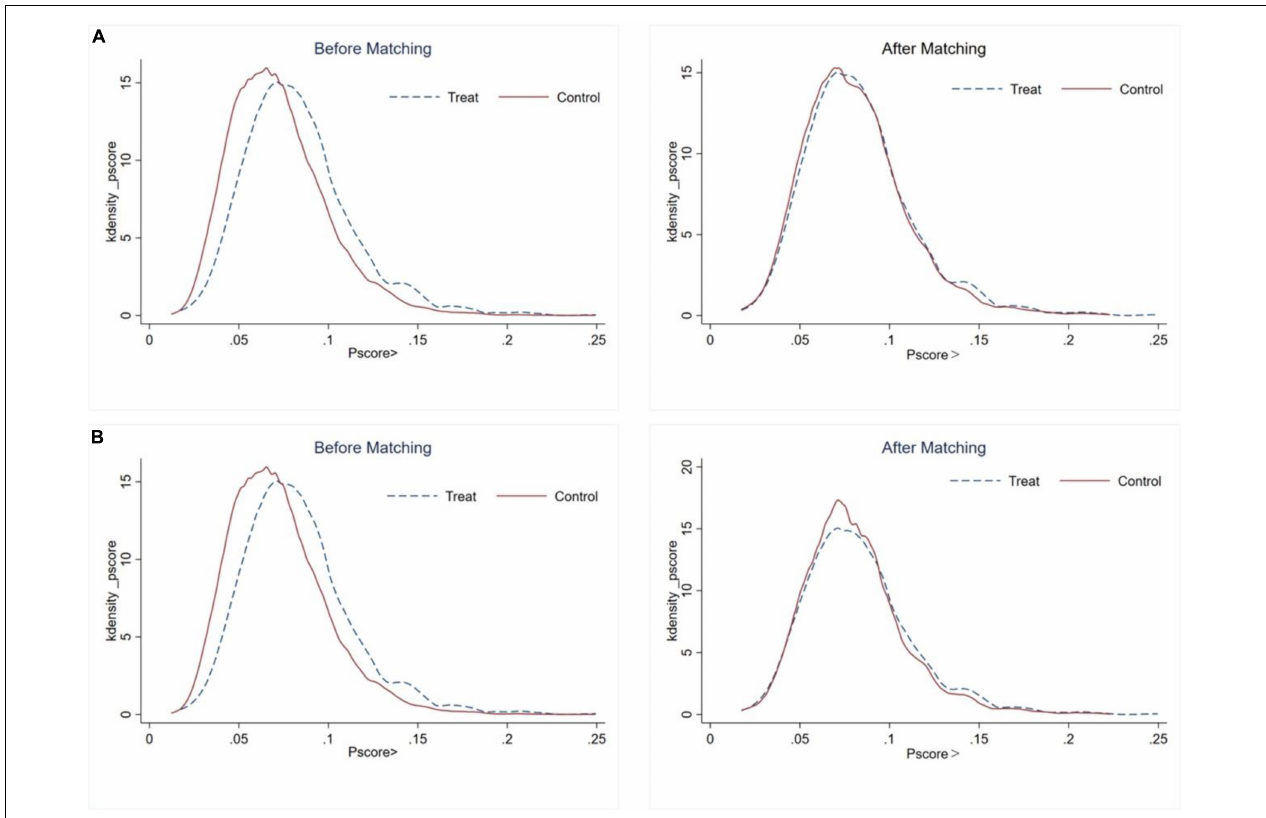
FIGURE 2 | Kernel density distribution of natural hazards before and after matching: (A) Subjective well-being; (B) Income. The solid line represents rural residents who have received the indicated intervention. —The dashed line represents rural residents who have not received the indicated intervention.